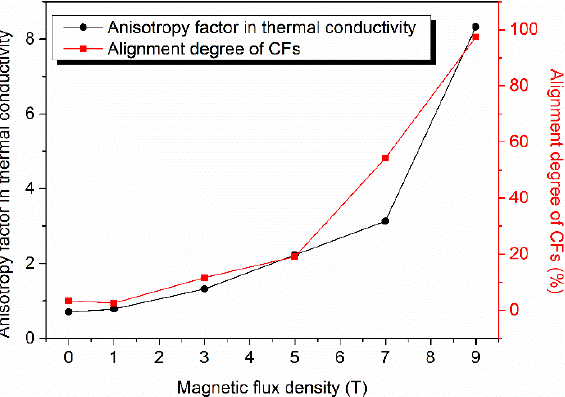
Figure 7. The effect of the alignment degree of CFs on theoretical through-plane thermal conductivity of the CF–rubber composites. ( a ) In-plane alignment; ( b ) random alignment; ( c ) through-plane alignment.